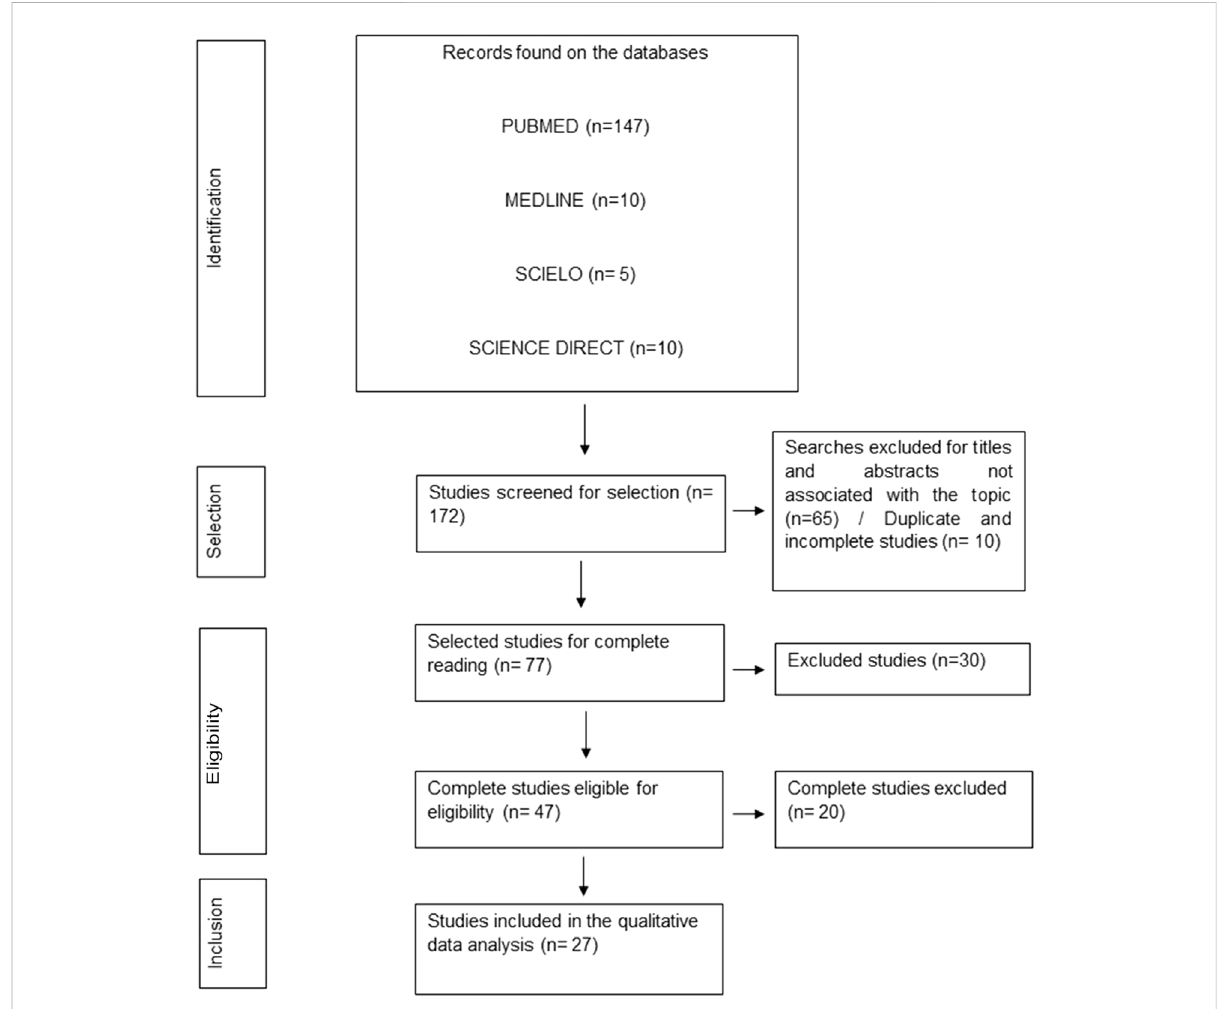
FIGURE 2 Flowchart representative of the stages of selection, eligibility, and inclusion of studies for